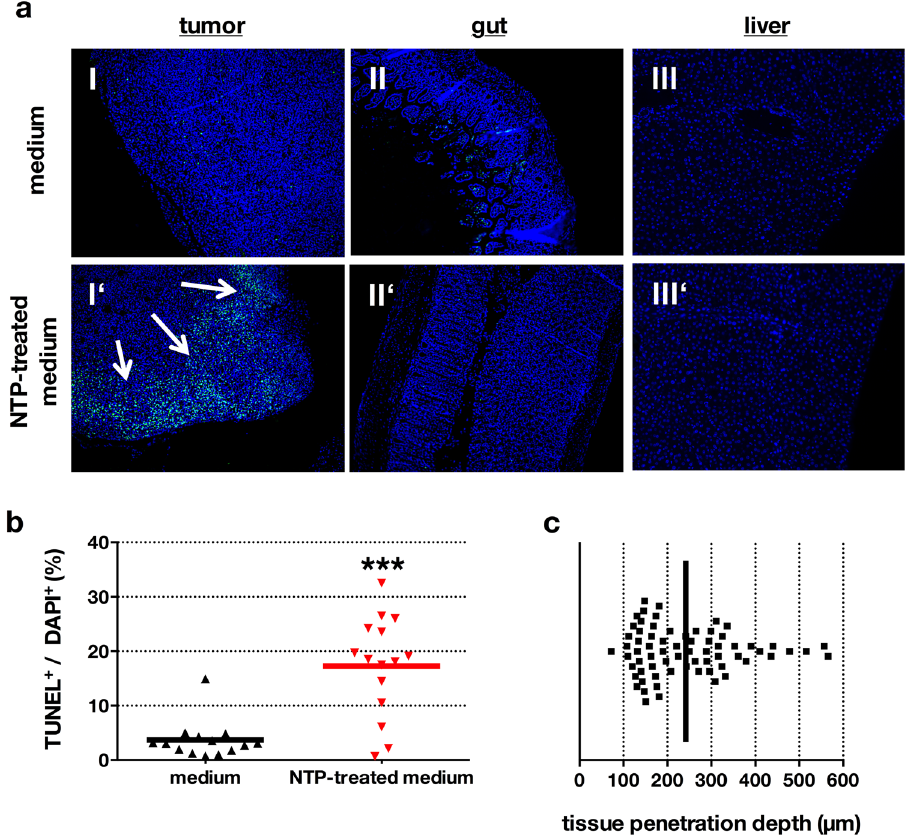
Figure 4. NTP-treated medium induced apoptosis in tumor tissue but not in the gut or liver. Tumor-bearing mice were sacrificed and tumor nodes (I, I ′ ), gut (II, II ′ ) and liver (III, III’) were removed. Paraffin tissue- sections were made and stained with TUNEL for apoptotic cells and DAPI for nuclei ( a ). TUNEL + /DAPI +